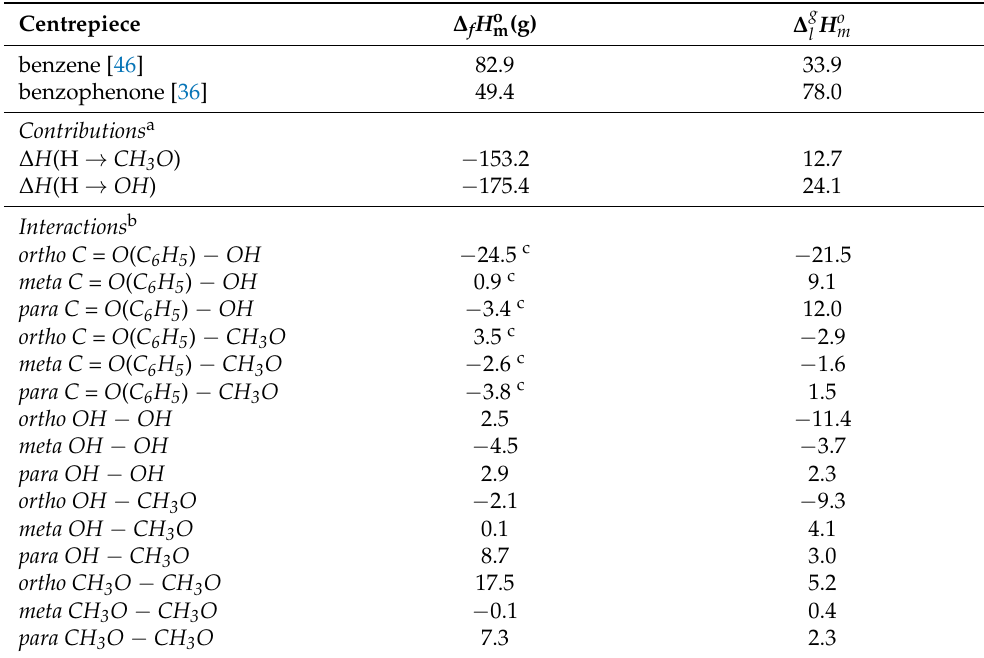
Table 9. Parameters and pairwise nearest and non-nearest neighbour interactions of substituents on the “centrepieces” for calculation of thermodynamic properties of substituted benzenes and benzophenones at 298.15 K (in kJ · mol − 1